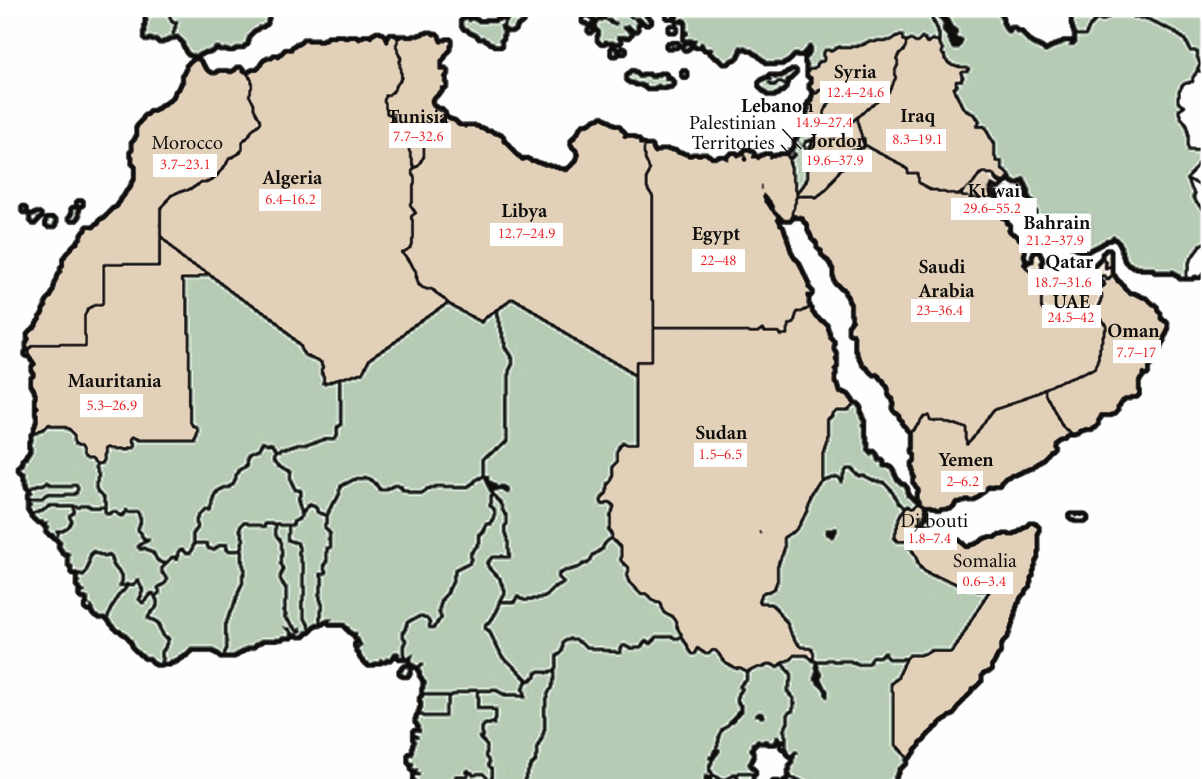
Figure 1: Prevalence of obesity in Arabian countries in adult males and females, respectively, aged between 15 and 100 years, WHO estimates,